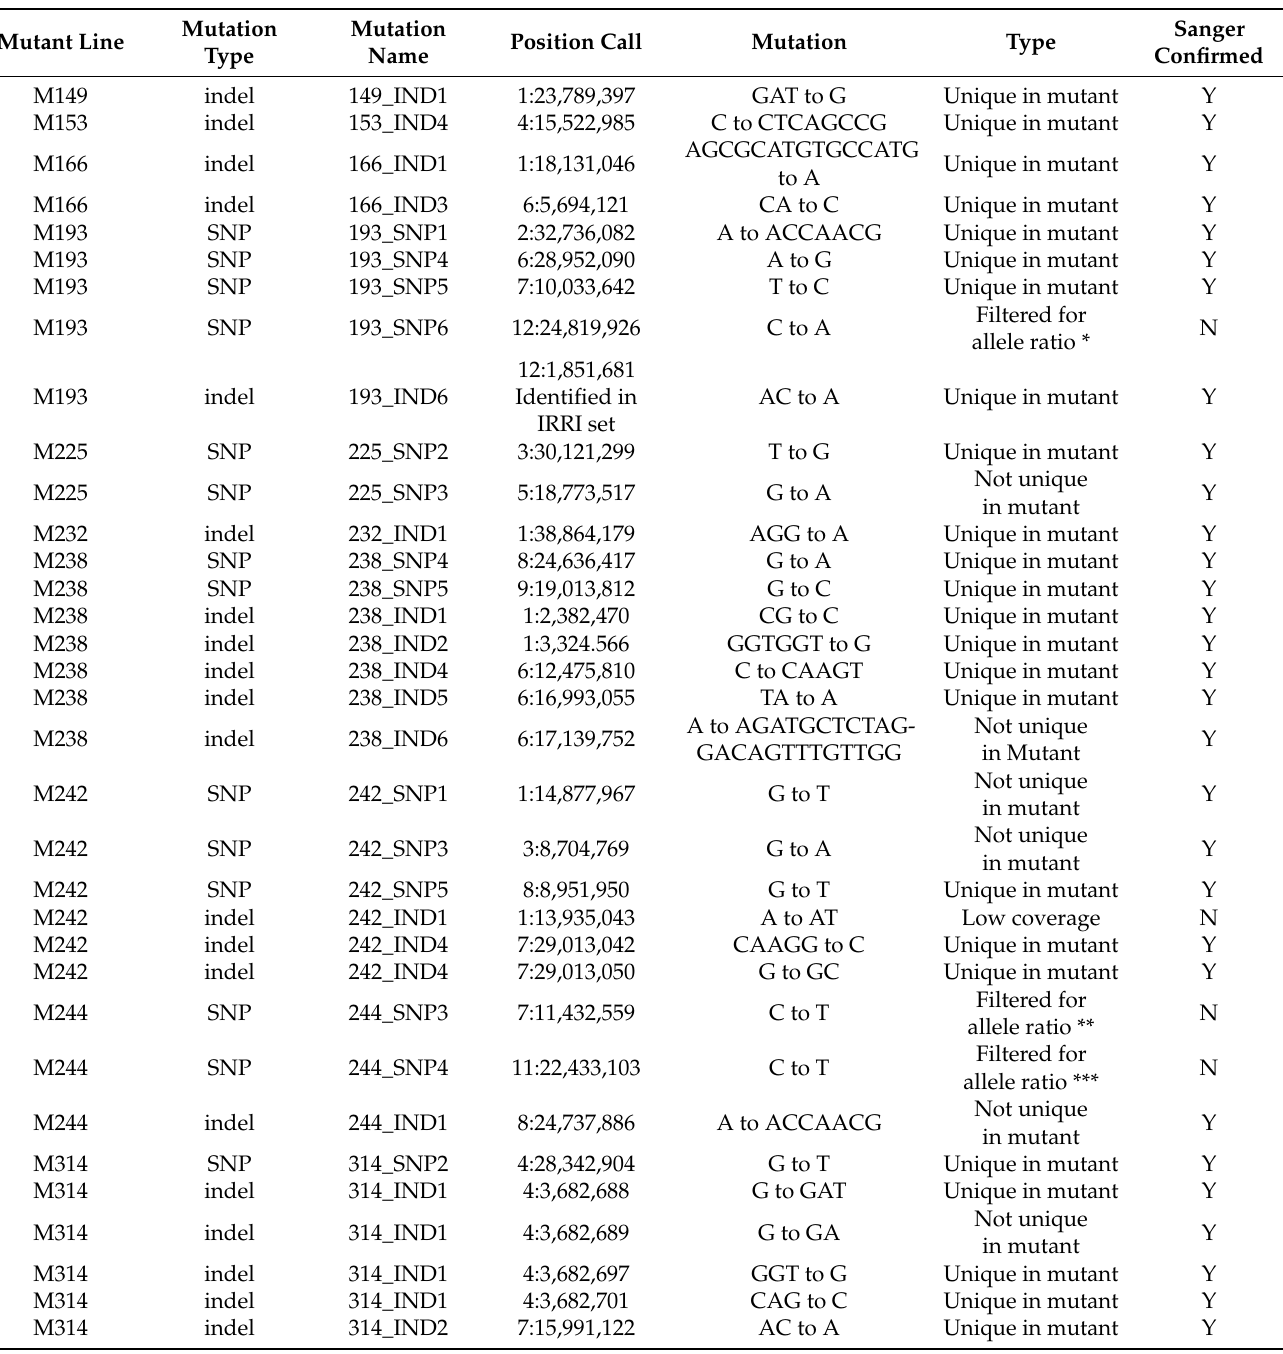
Table 4. Validation of variants by Sanger sequencing.